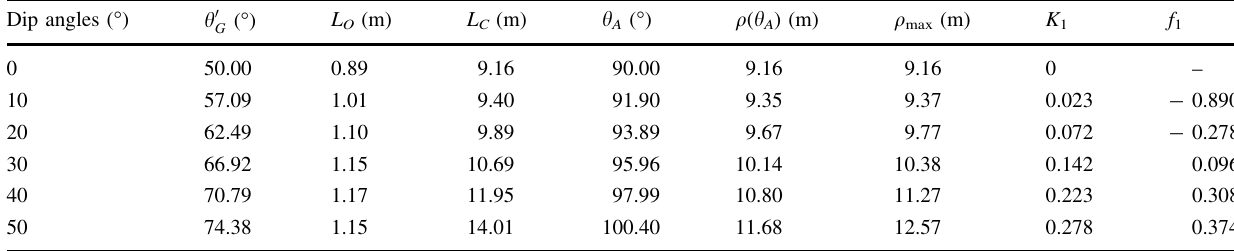
Table 1 Drawing body parameters for different seam dip angles in the initial drawing stage Dip angles ( (cid:3)